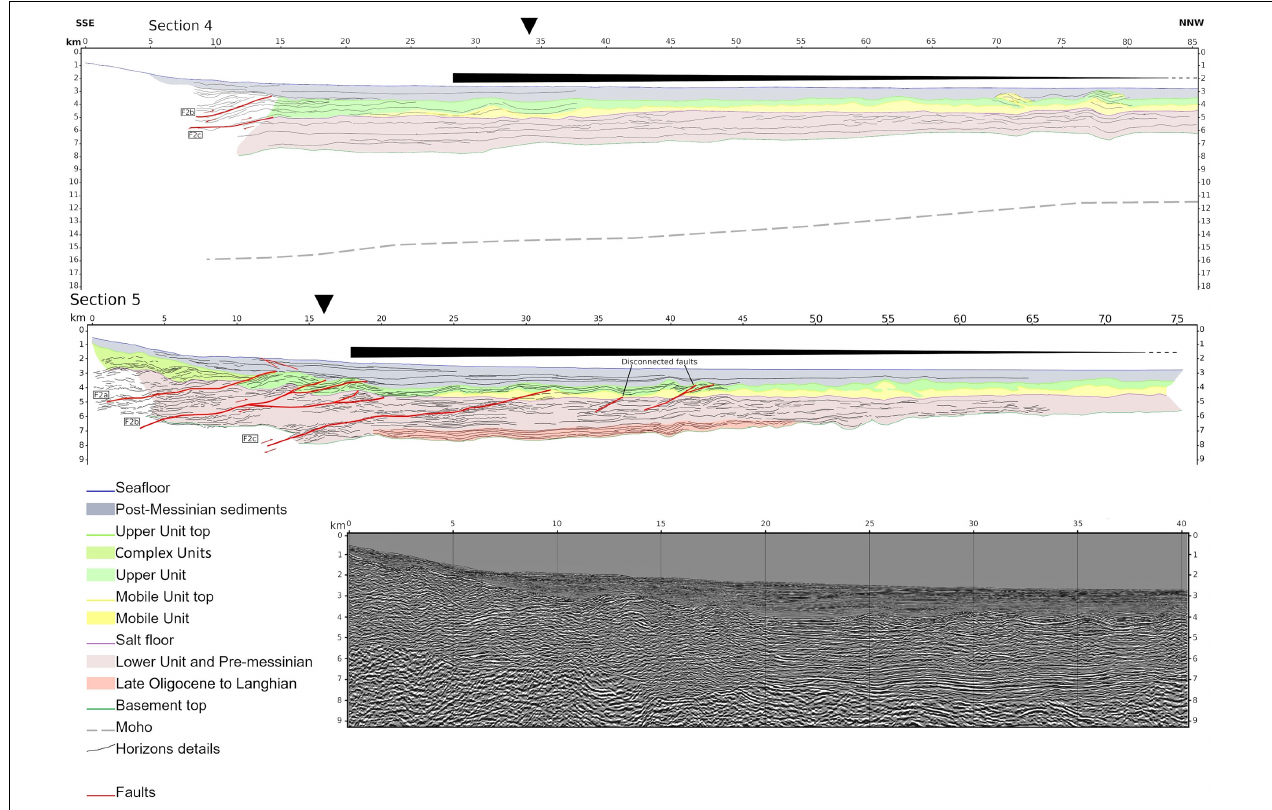
FIGURE 7 | Seismic Section 4 (southern half of the seismic section only) and 5 (continental margin only) off Jijel , as depth-converted line drawings. No vertical exaggeration is present. Major horizons and faults are identified, as well as major asymmetric basins. Section 4 evidences the flexure of the basin; its reduced length is due to both the great length of the profile and the absence of any significant geological feature on the second half of the profile with the exception of the global deepening of the horizons toward the margin. Section 5 resolution is higher than the one of Section 4 and goes further onto the continental margin, but it is also shorter and has thus been integrated only to display the faulting system. Light green unit in the margin corresponds to the Complex unit (CU) coeval to UU and deposited in response to the major sea level drop of the Messinian Salinity Crisis. Stretched triangle: same as Figure 6 . Downward pointing arrow locates